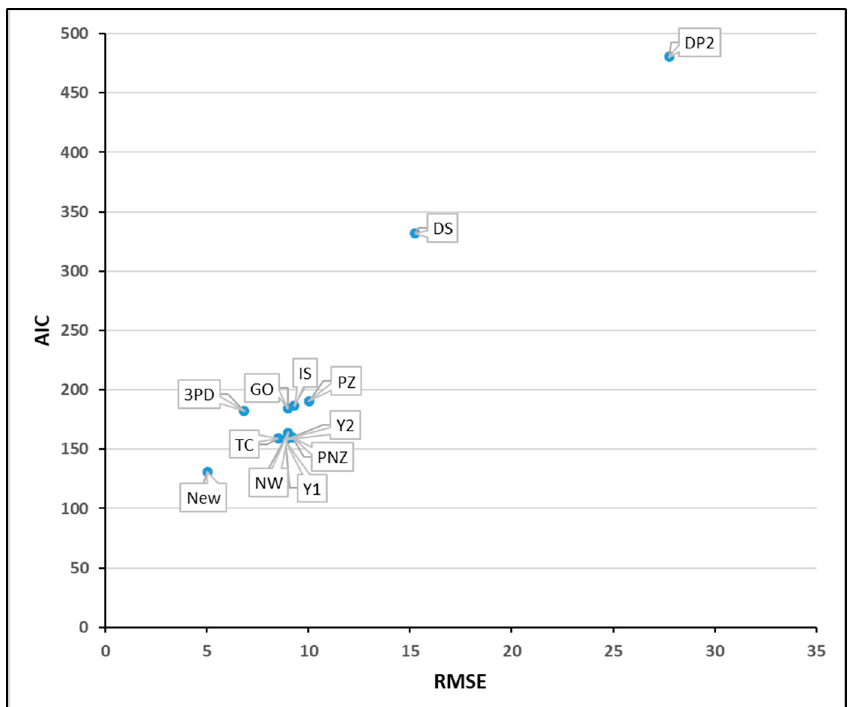
Figure 12. Comparison of RMSE and AIC for Dataset #2.